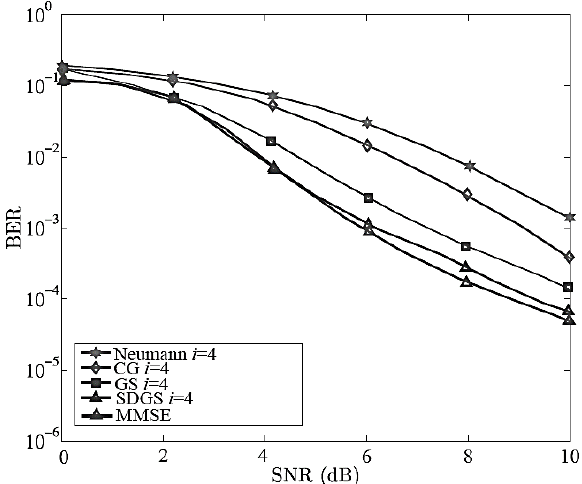
Figure 4. Hard decision bit error rate (BER) performance comparison with high fading level at 128 × 16 antenna configuration.